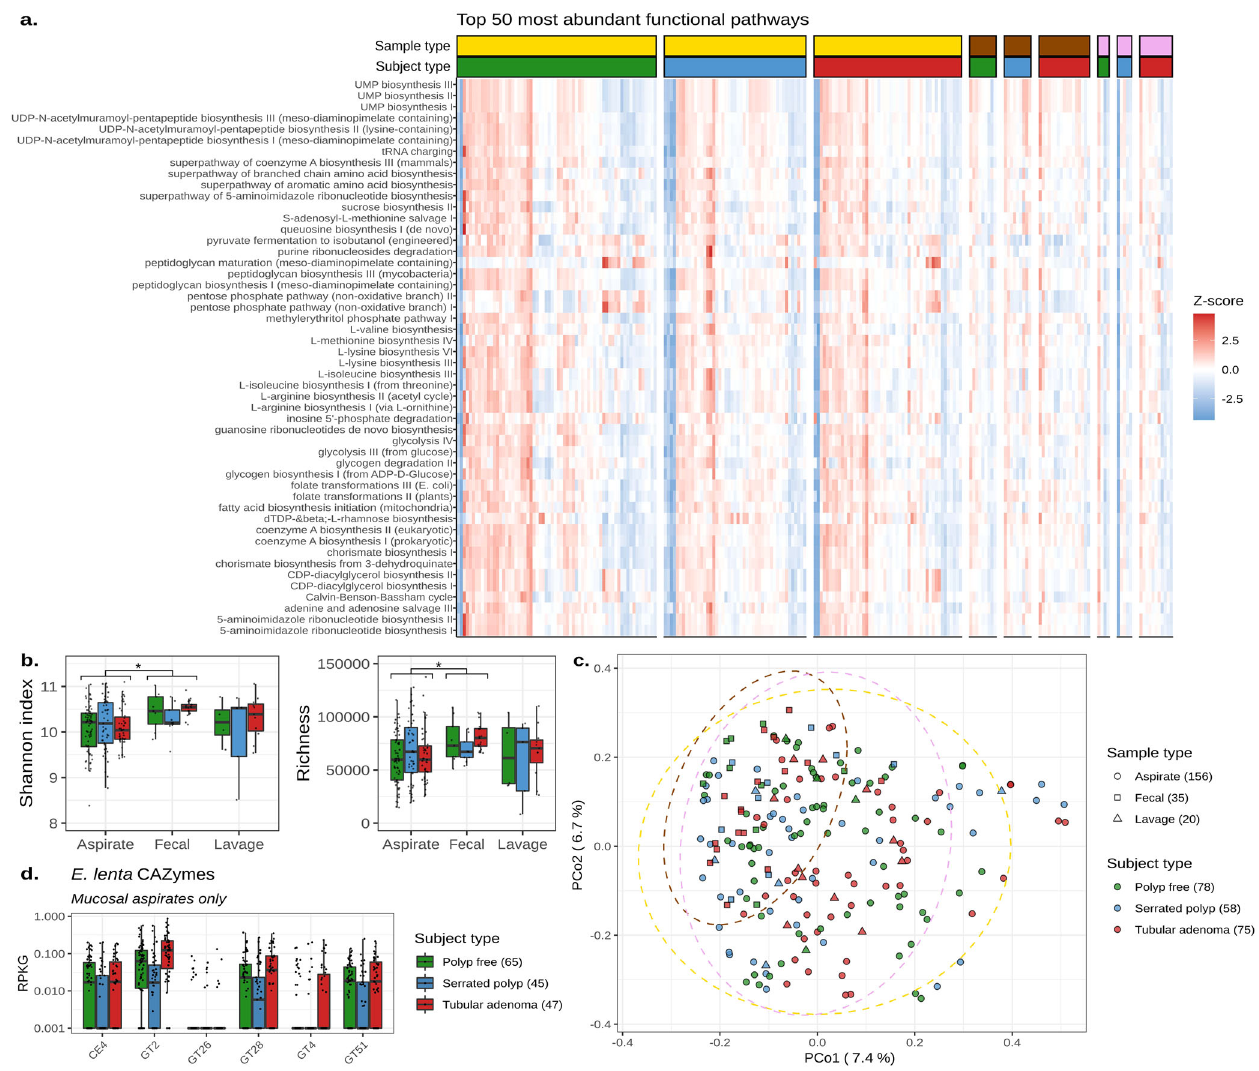
Fig. 5 Microbiome functional potential is distinct across sampling methods and subject types. a A heatmap displaying the z -scores of the top 50 most abundant microbial pathways found within the second sample set. Each column is one sample, with multiple samples per individual. Samples are clustered by sample and subject types. Yellow represents mucosal aspirates, brown represents fecal samples, and purple represents lavage aspirates. Within-subject types, green represents polyp-free samples, blue represents serrated polyp samples, and red represents tubular adenoma samples. b Box plots showing the Shannon diversity and richness of individual microbial genes across the second sample set mucosal aspirates, lavage aspirates, and fecal samples. Signi fi cant comparisons (Linear-mixed effects: p < 0.05) are denoted with an asterisk (*). c Principal coordinate analysis of per-gene Bray – Curtis dissimilarities. Each point represents one sample. Ellipses are drawn to represent the 95% con fi dence interval of each sample type ’ s distribution. The number of samples per sampling method and subject type are annotated parenthetically. d Box plots showing the abundance of E. lenta -speci fi c carbohydrate-active enzymes in reads per kilobase per genome equivalent. Only mucosal aspirates from the second sample set are shown, with the number of mucosal aspirates per subject type being denoted parenthetically. The center line within each box de fi nes the median, boxes de fi ne the upper and lower quartiles, and whiskers de fi ne 1.5x the interquartile range. Source data are provided as a Source Data fi